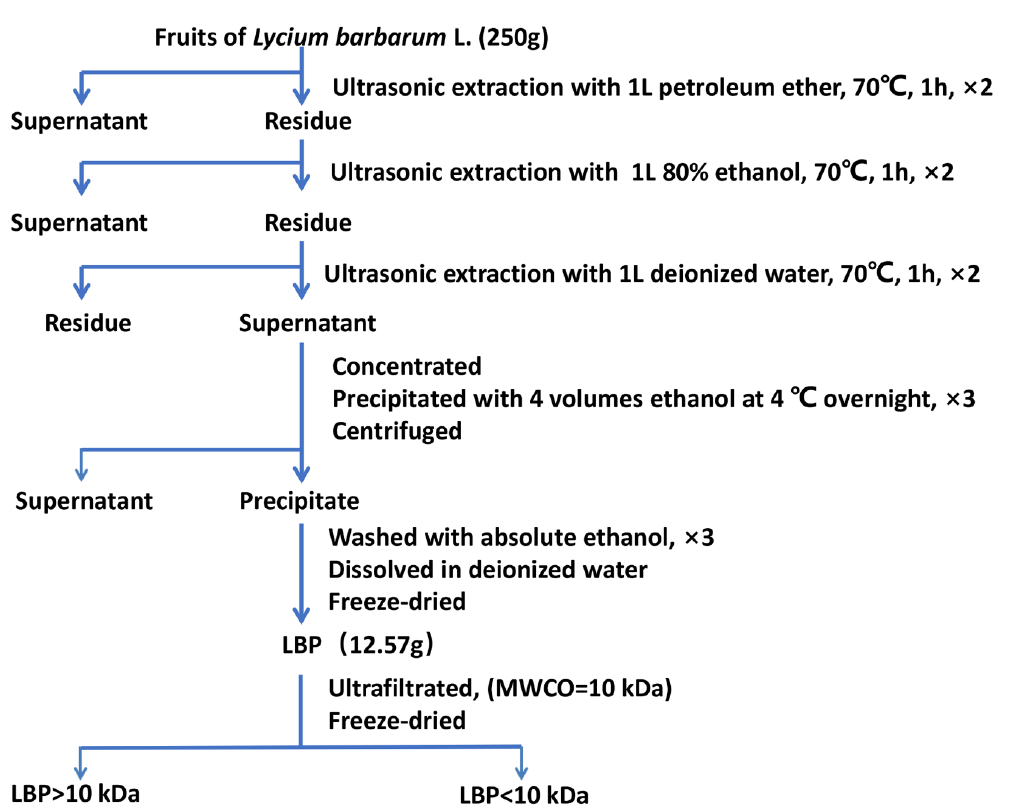
Figure 1. Extraction scheme and isolation process of LBP from Lycium barbarum L. fruit. Table 1. Structure Characterization of LBP